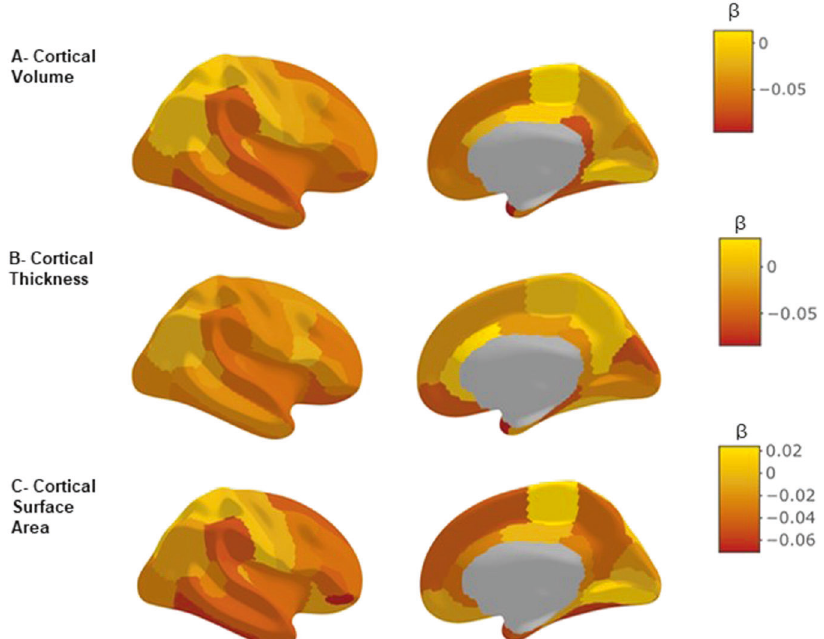
Fig. 3 Brain map of the standardised effect sizes for hair cortisol associations with 34 regional cortical volumes, cortical thicknesses and cortical surface areas. A Cortical volume, B cortical thickness, and C cortical surface area. ß represents the standardised effect size. All associations are corrected for age, sex, study site, intracranial volume, imaging batch, imaging edits and